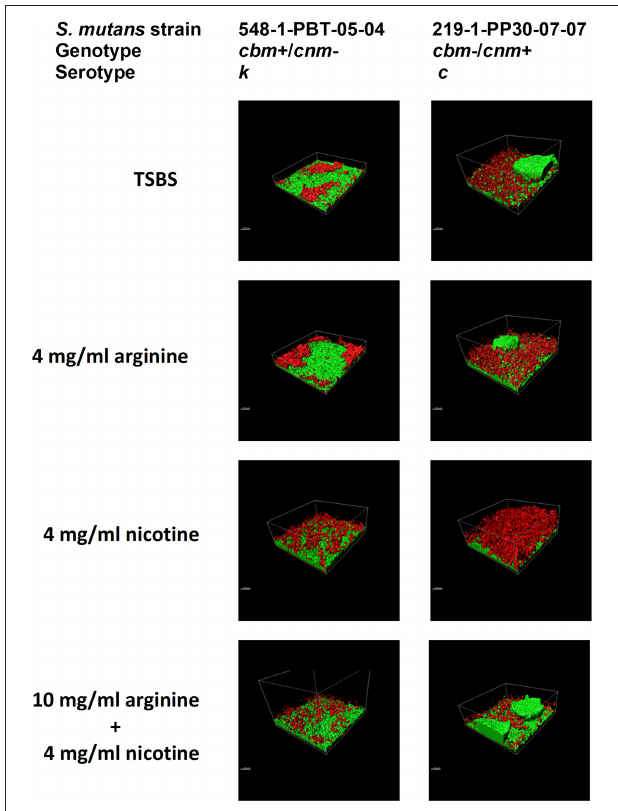
FIGURE 2 | S. mutans bacterial cells and EPS from 24h biofilm measured by CLSM. Alexa Fluor 568 labeled dextran (red) was added at the beginning of biofilm formation to label the EPS as it was synthesized. Arginine and nicotine were added simultaneously with the Alexa Fluor 568 labeled dextran. Prior to imaging the 24h biofilm, S. mutans DNA was labeled with Syto 9 (green). Representative processed Z-stack images from CLSM analyses of biofilm from two selected strains of S. mutans grown in TSBS alone, 10 mg/ml arginine, 4 mg/ml nicotine or 10 mg/ml arginine + 4 mg/ml nicotine are shown.